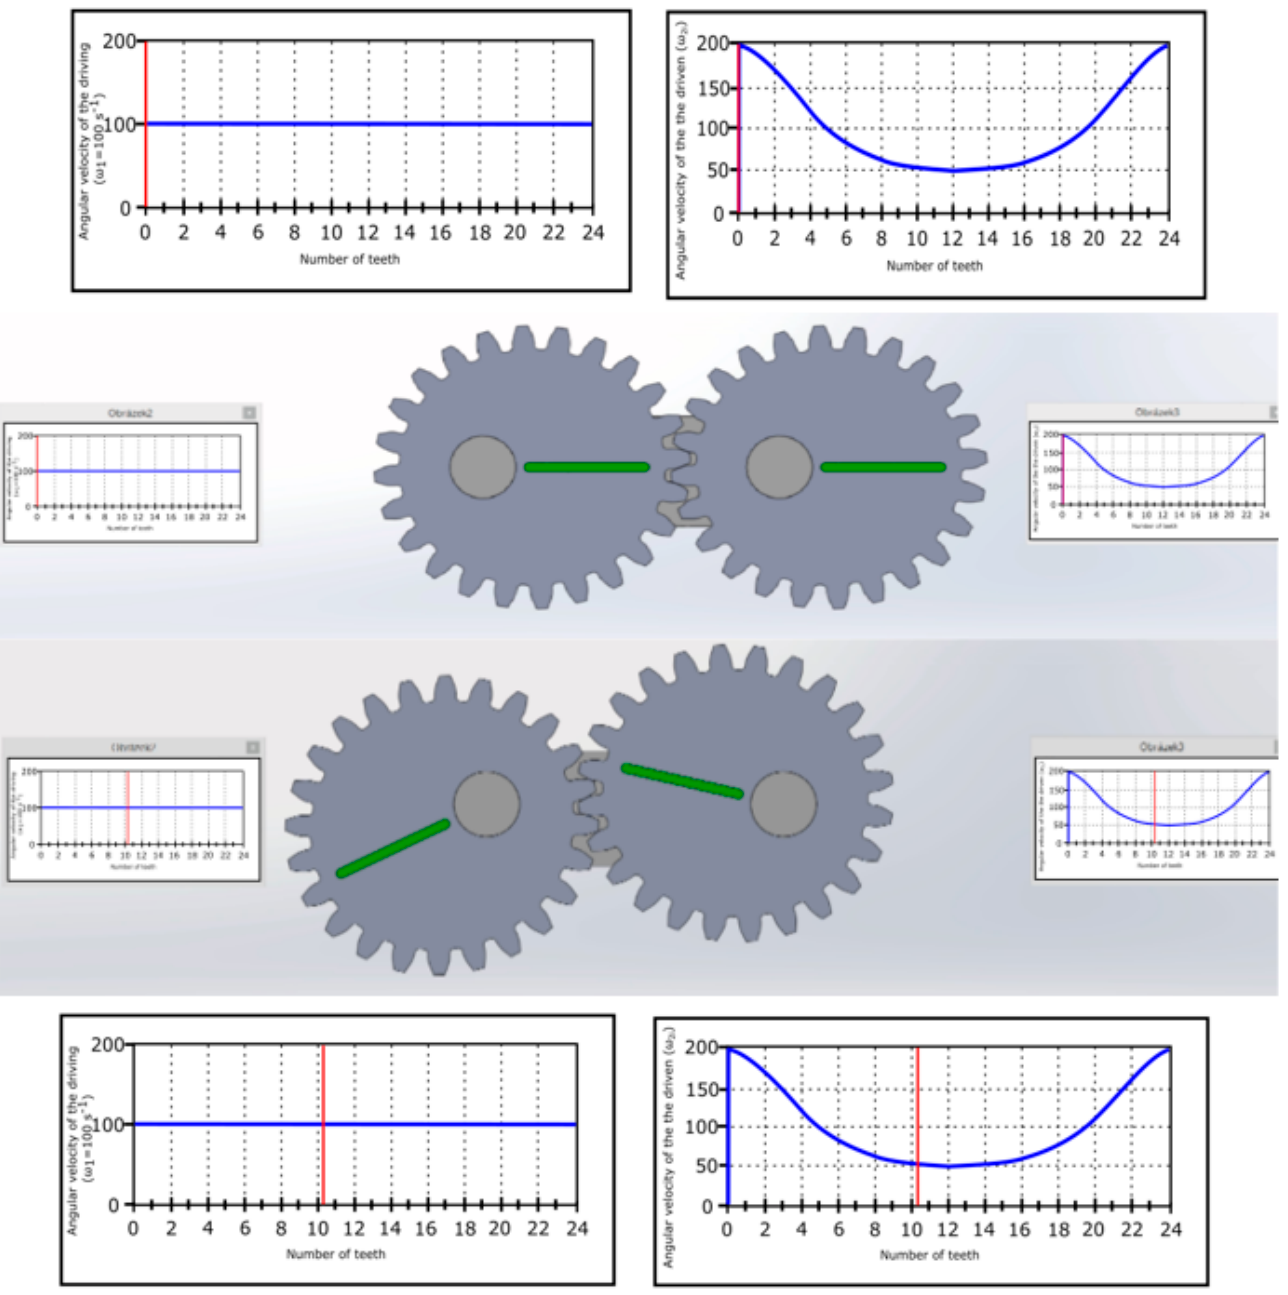
Figure 29. Motion analysis by SolidWorks.